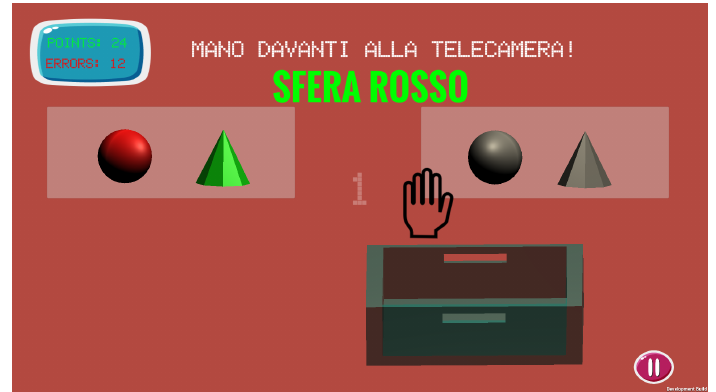
Figure 3. Game scenario during Level 4 of the GDD exergame. The user has to select the red sphere, but the instruction is written in green. The box is moving and the time is expiring (appreciable from the red background and the 1 second left to complete the